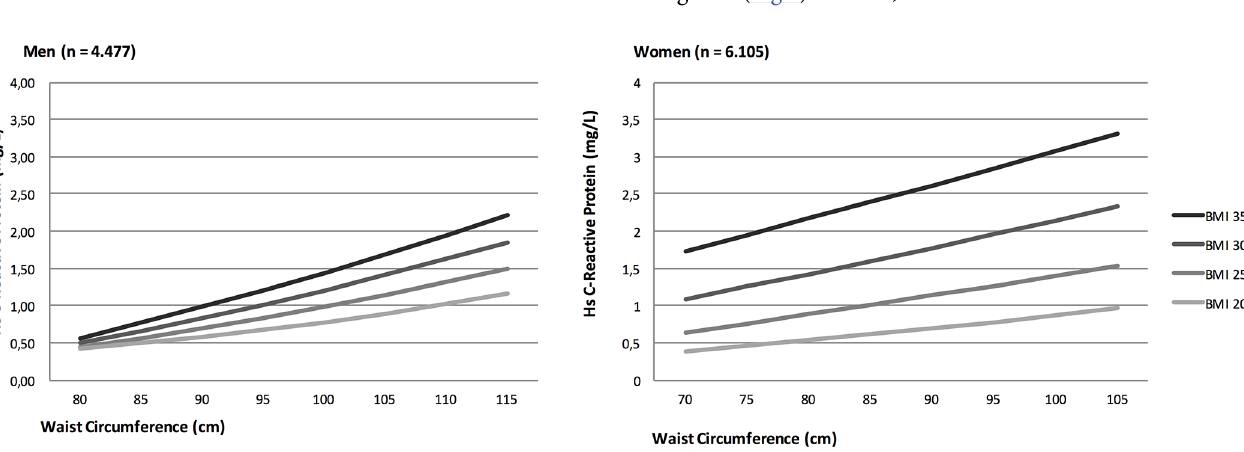
PLOS ONE | https://doi.org/10.1371/journal.pone.0190645 January 17,